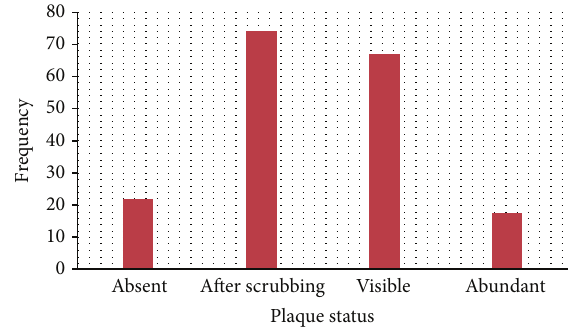
Figure 2: Distribution of population according to the amount of plaque present.